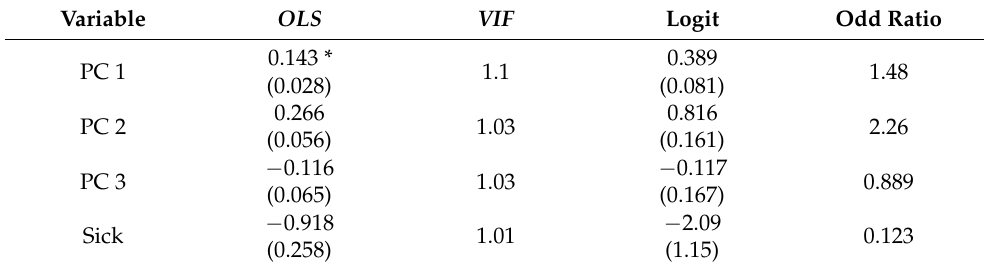
Table A7. Principal components regression results for Energy with Sick and Male as